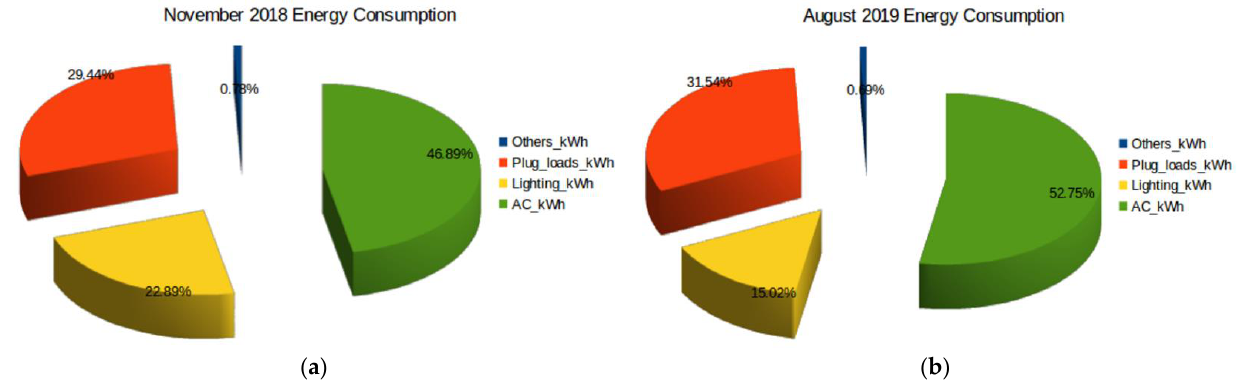
Figure 4 . HVAC consumption: ( a ) November 2018, ( b ) August 2019. Figure 4. HVAC consumption: ( a ) November 2018, ( b ) August